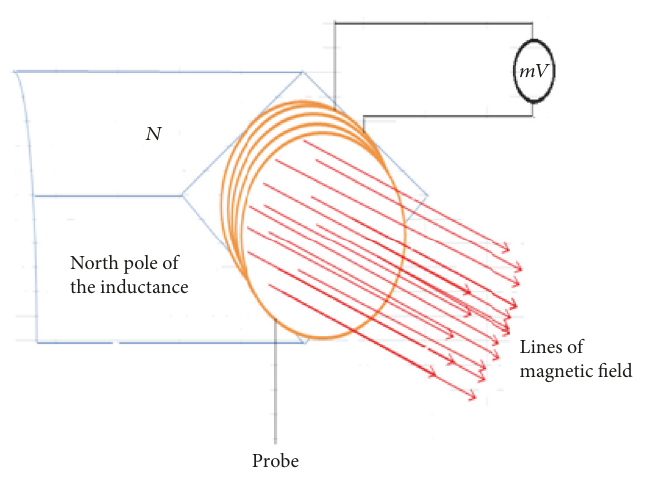
Figure 3: Device (probe) used for the measurement of the magnetic